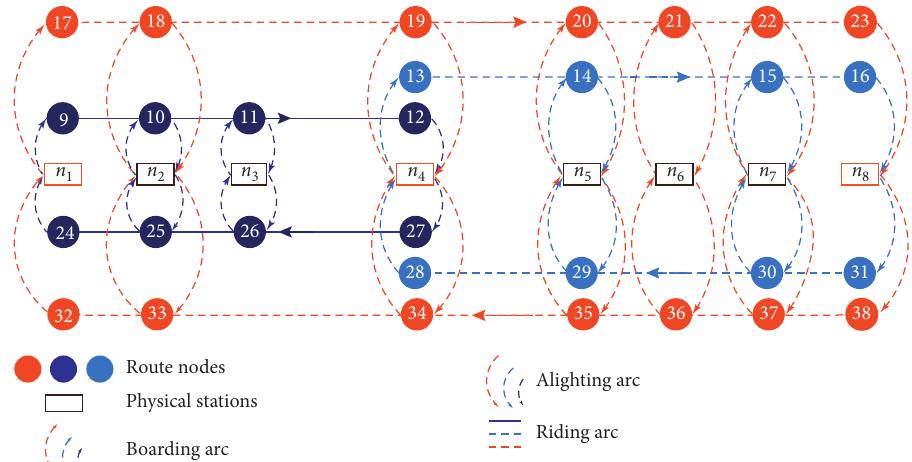
Figure 3: Description of directed service